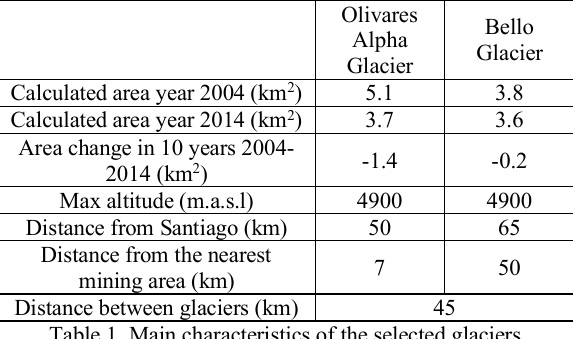
Table 1. Main characteristics of the selected glaciers